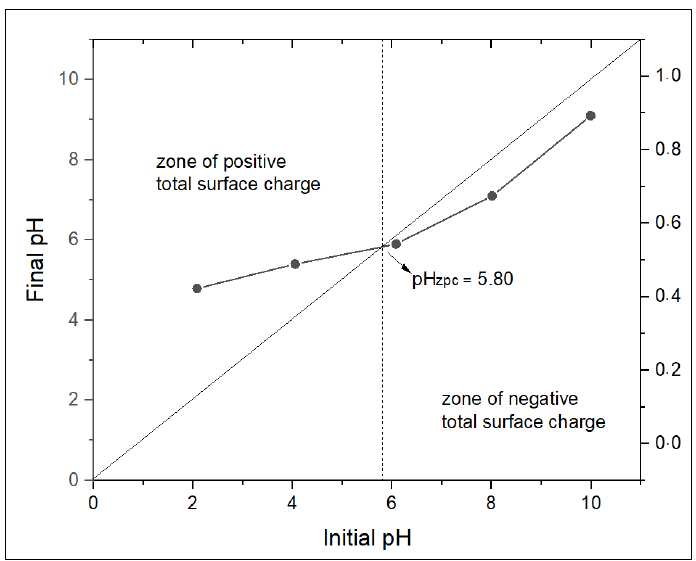
Figure 3. Zero-point charge of coconut shell biomass by pH drift method.